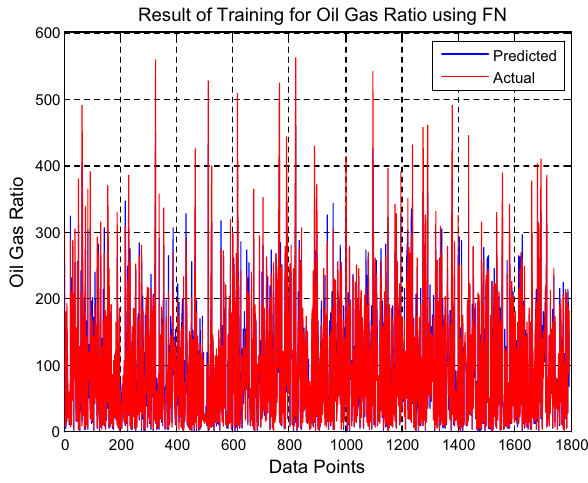
Fig. 8 Predicted and the actual R FN for